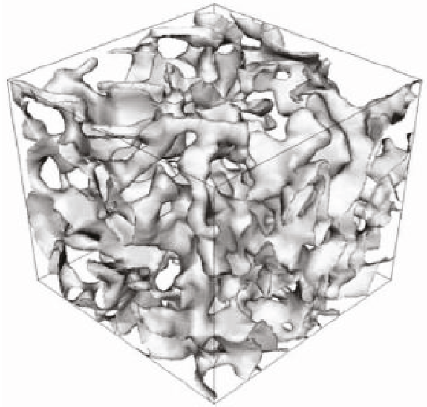
Figure 3: The use of X-ray CT scanning method is the establishment of a 3D digital core. The transparent part is the skeleton; the other part is the